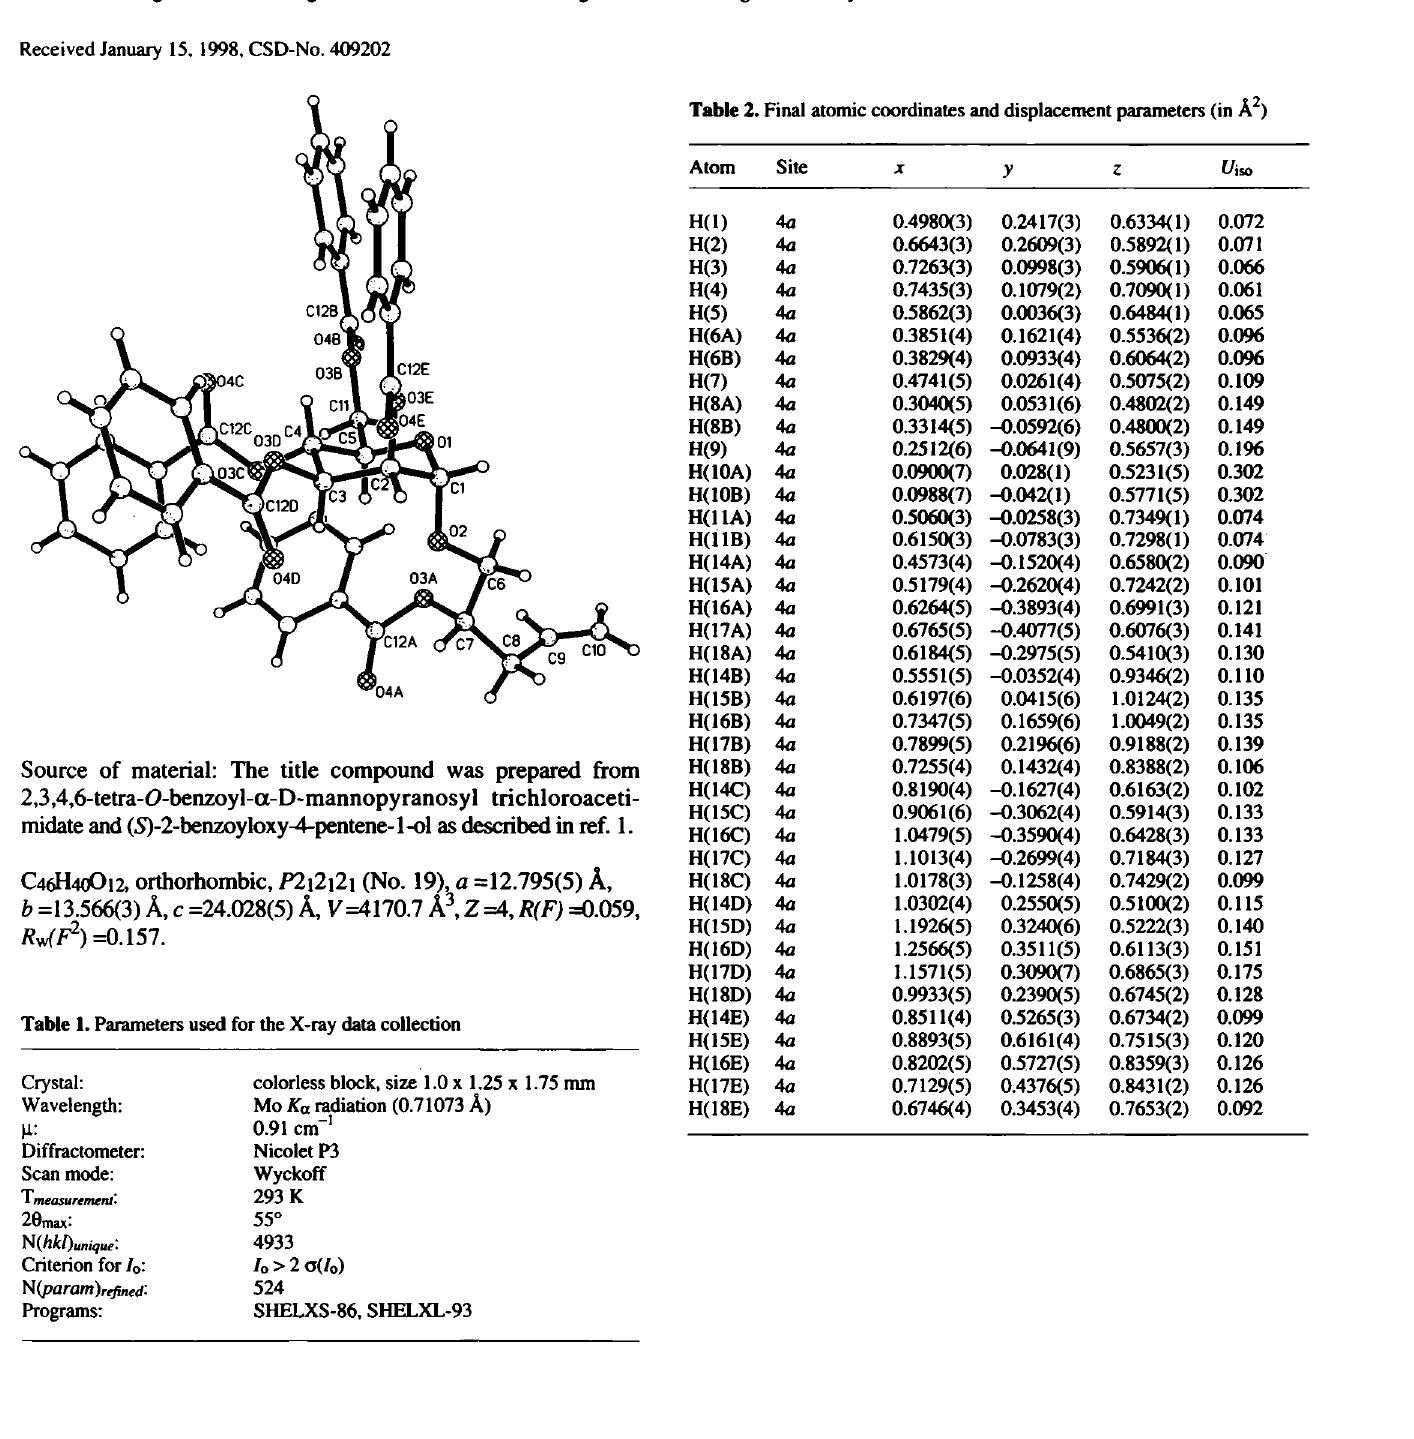
Table 2. Final atomic coordinates and displacement parameters (in